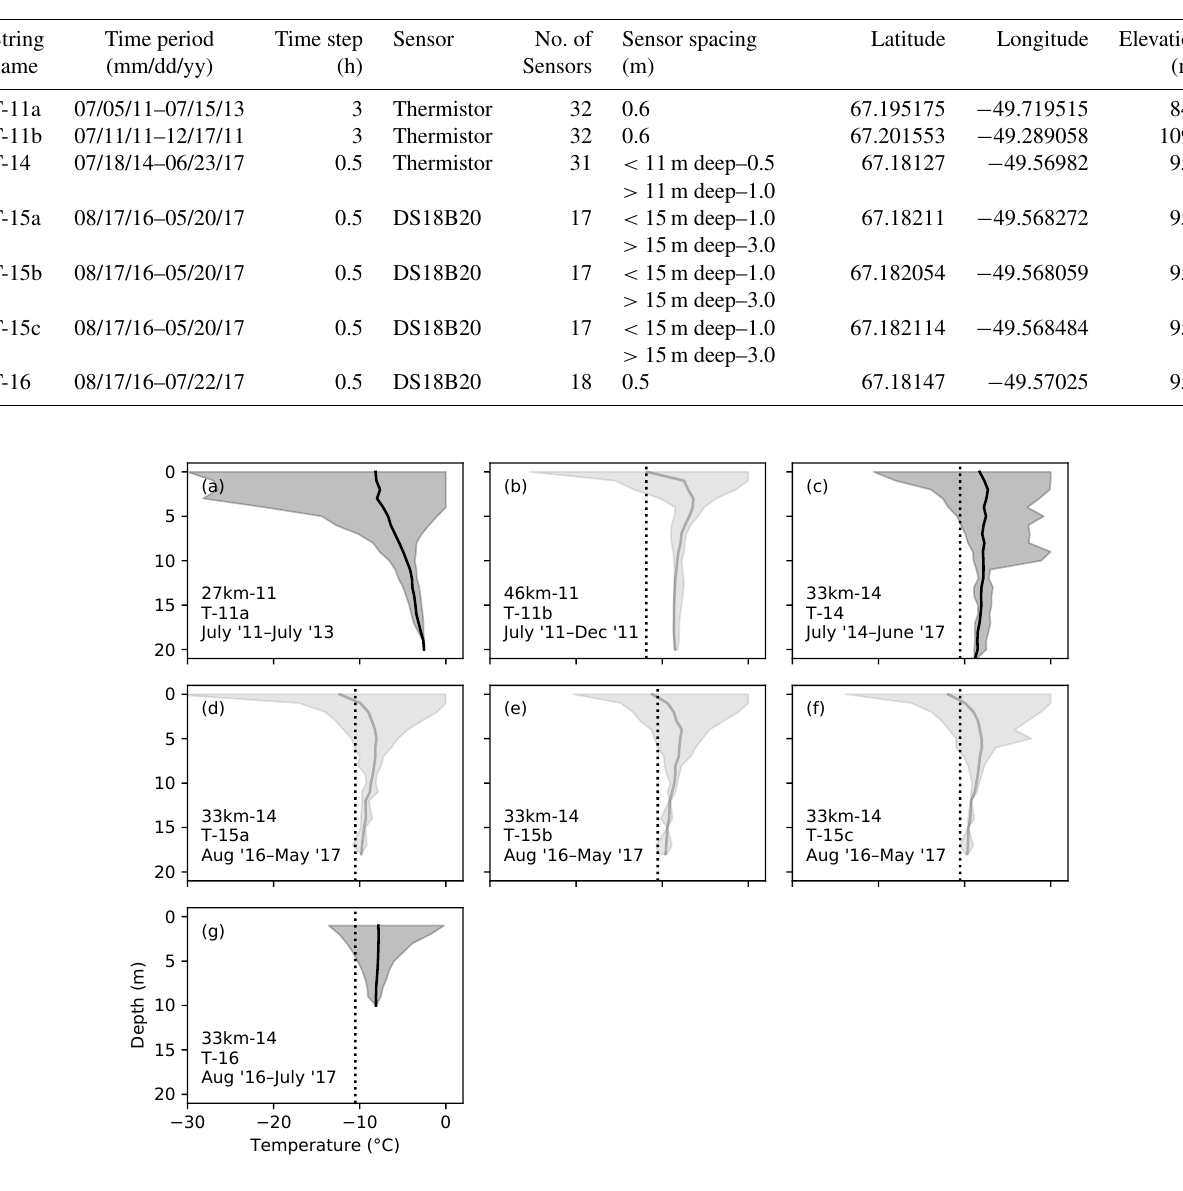
Figure 2. Near-surface ice temperature measurements from seven strings: T-11a, T-11b, T-14, T-15a, T-15b, T-15c, and T-16. For each, the shaded region shows the range of measured temperatures over the entire measurement period, and the solid line indicates the mean temperature profile. Depths are plotted with respect to the surface at the time of measurement, so sensor locations move toward the surface as ice melts. Strings with less than 11 months of data are slightly more transparent. For field sites at which the air temperature was measured for at least a full year, a dashed line shows the mean air